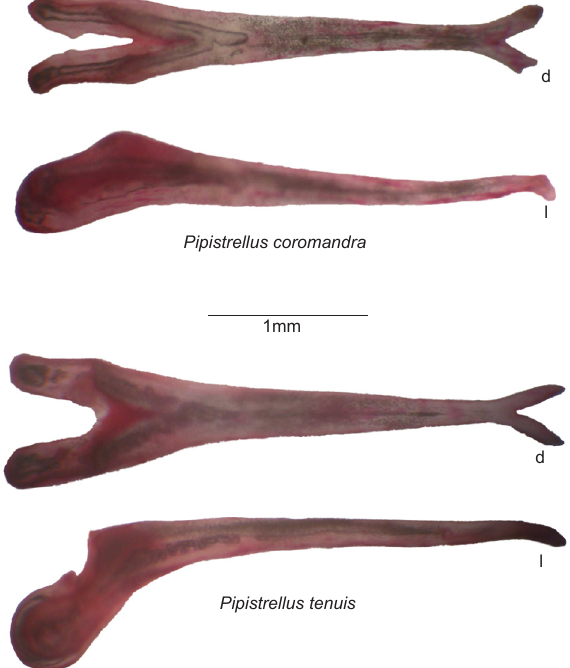
Figure 3. Dorsal (d) and lateral (l) views of the bacula of Pipistrellus coromandra (CDZ TU_BAT 022) and Pipistrellus tenuis (CDZ TU_BAT